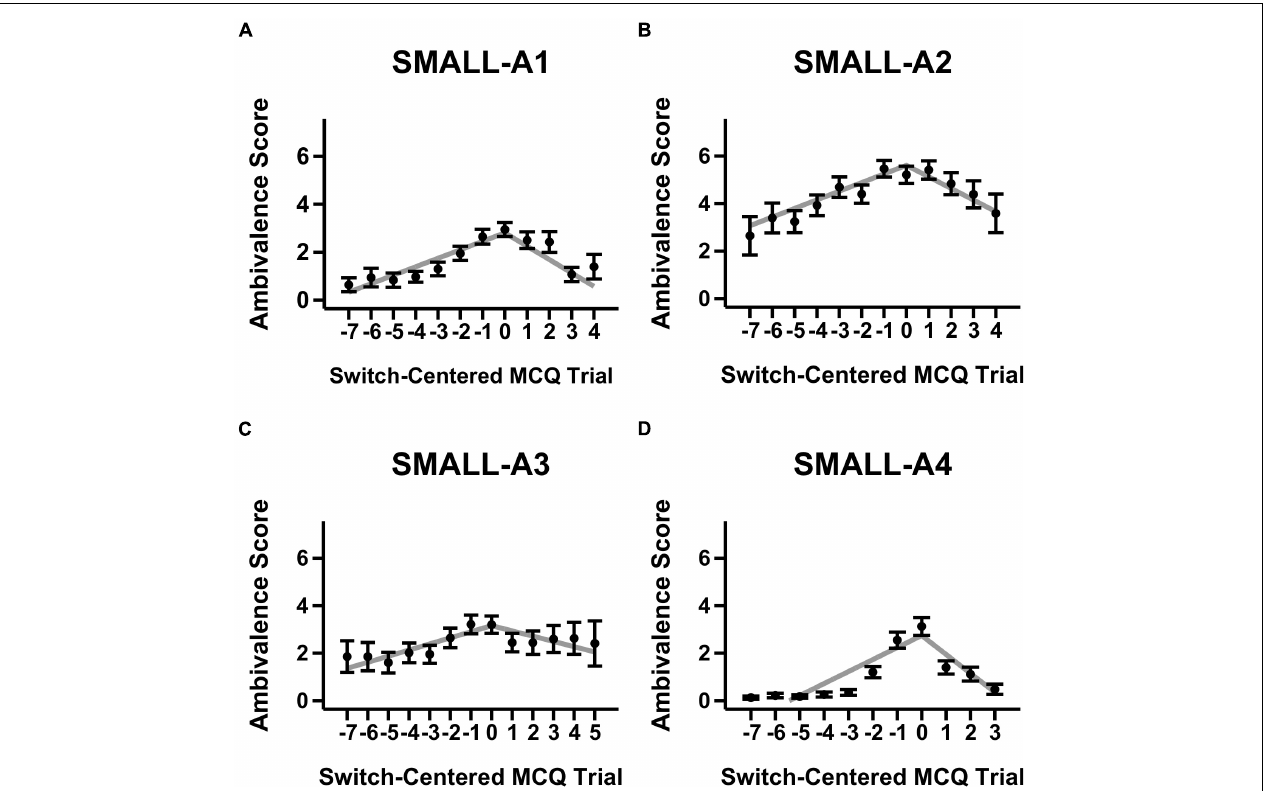
FIGURE 1 | Mean ambivalence scores and dual-slopes mixed model predictions for small magnitude trials split by ambivalence measurement condition. X-axis denotes the MCQ trial number centered by switch trial, Y-axis denotes the degree of ambivalence, and the panels denote the specific magnitude-ambivalence pairing: (A) Small-A1; (B) Small-A2; (C) Small-A3; (D) Small-A4. Black points indicate the trial-level means in self-reported ambivalence scores with standard error bars. Gray lines indicate the predicted ambivalence scores from the dual-slopes mixed